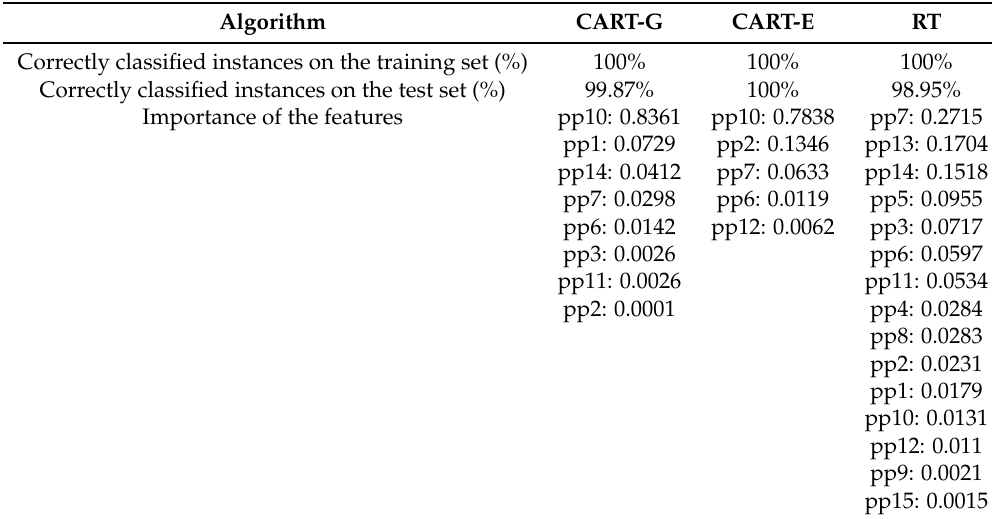
Table 2. Results for the selected algorithms. G, Gini; E, entropy.